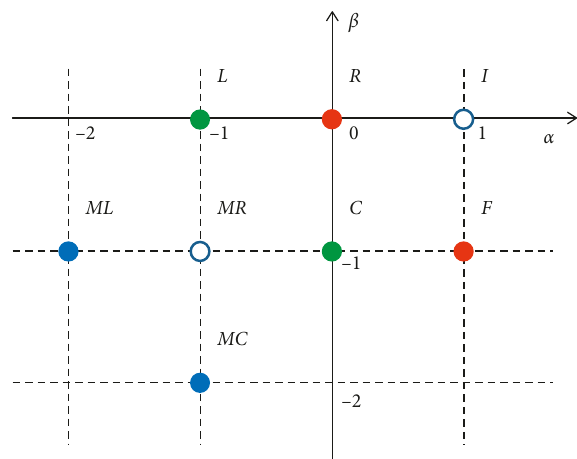
Figure 2: All currently known elements from Chua’s table. R , L , C � resistor, inductor, capacitor; MR , ML , MC � memristor, meminductor, memcapacitor; I , F � inerter,